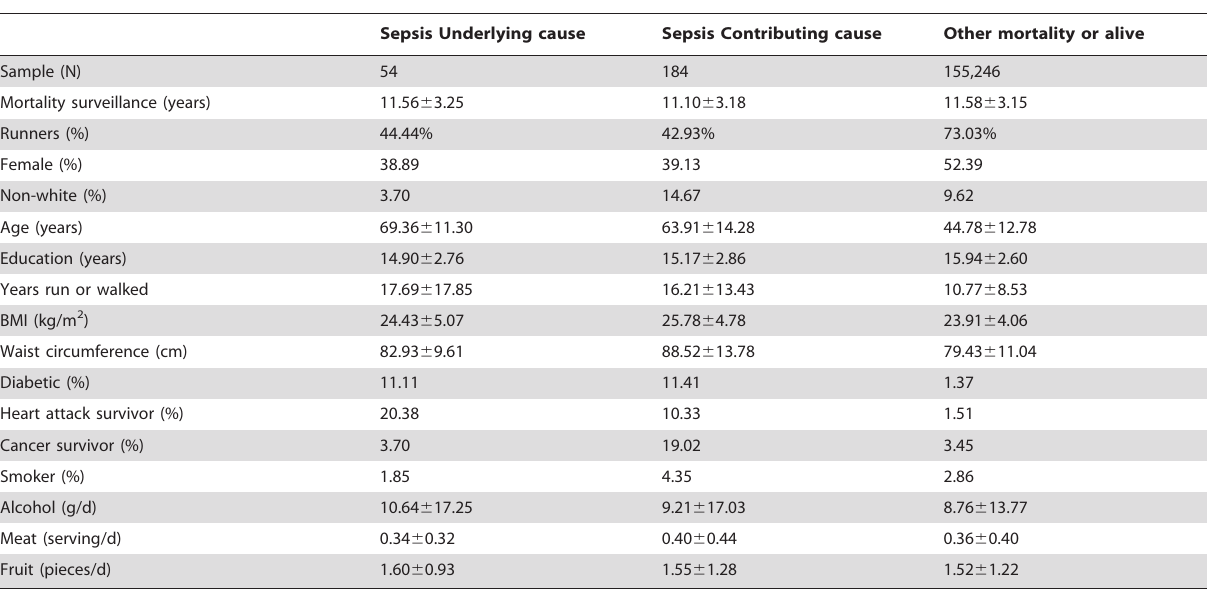
Table 1. Sample baseline characteristics (percent or mean 6 SD).